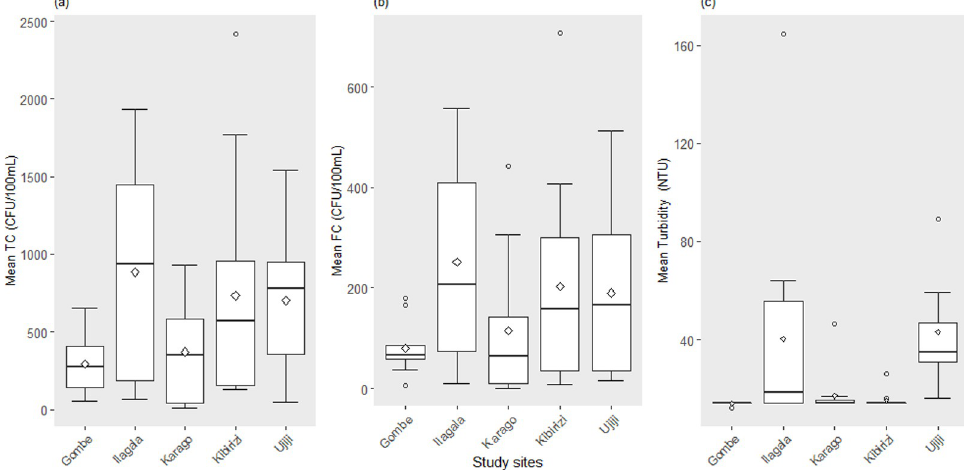
Fig 3. Boxplot representing mean concentrations ± standard deviation of coliform and turbidity determined by citizen scientists in 5 study sites (n = 36 per site). (a) Mean total coliform counts (CFU/100 mL) (b) Mean fecal coliform counts (CFU/100mL) (c) Mean Turbidity (NTU). Bars represent standard deviation and points represent variation around mean.